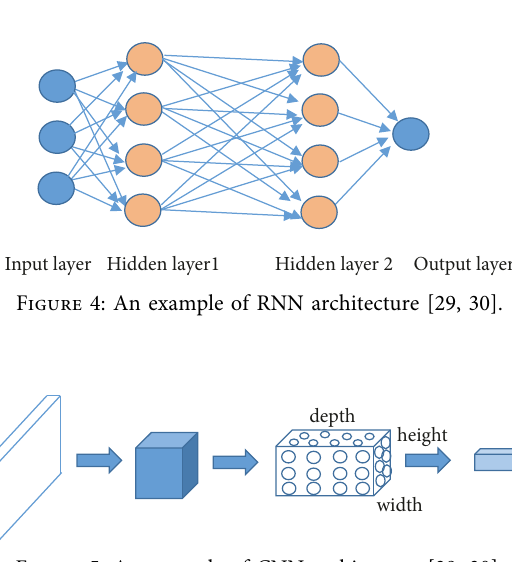
Figure 5: An example of CNN architecture [29,